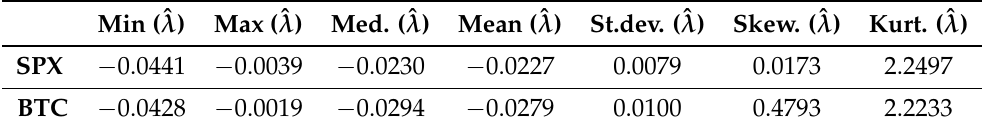
Table 2. Descriptive statistics of the volatility risk premium time series for SPX and BTC